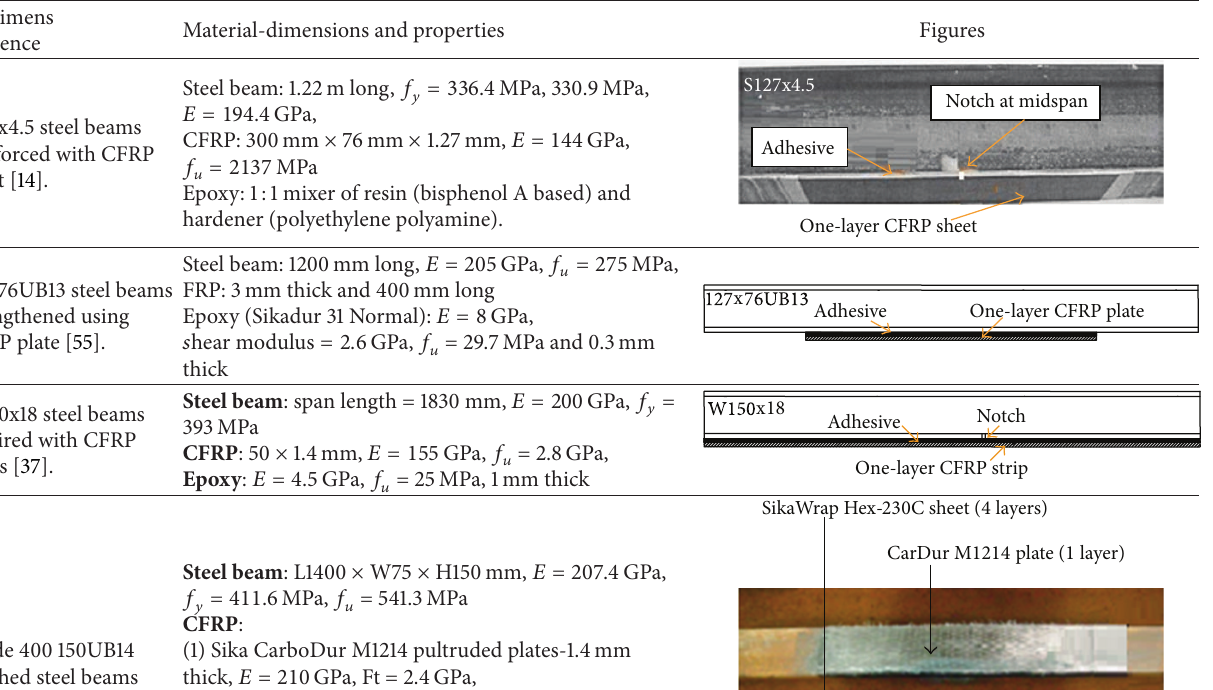
Table 1: Strengthening